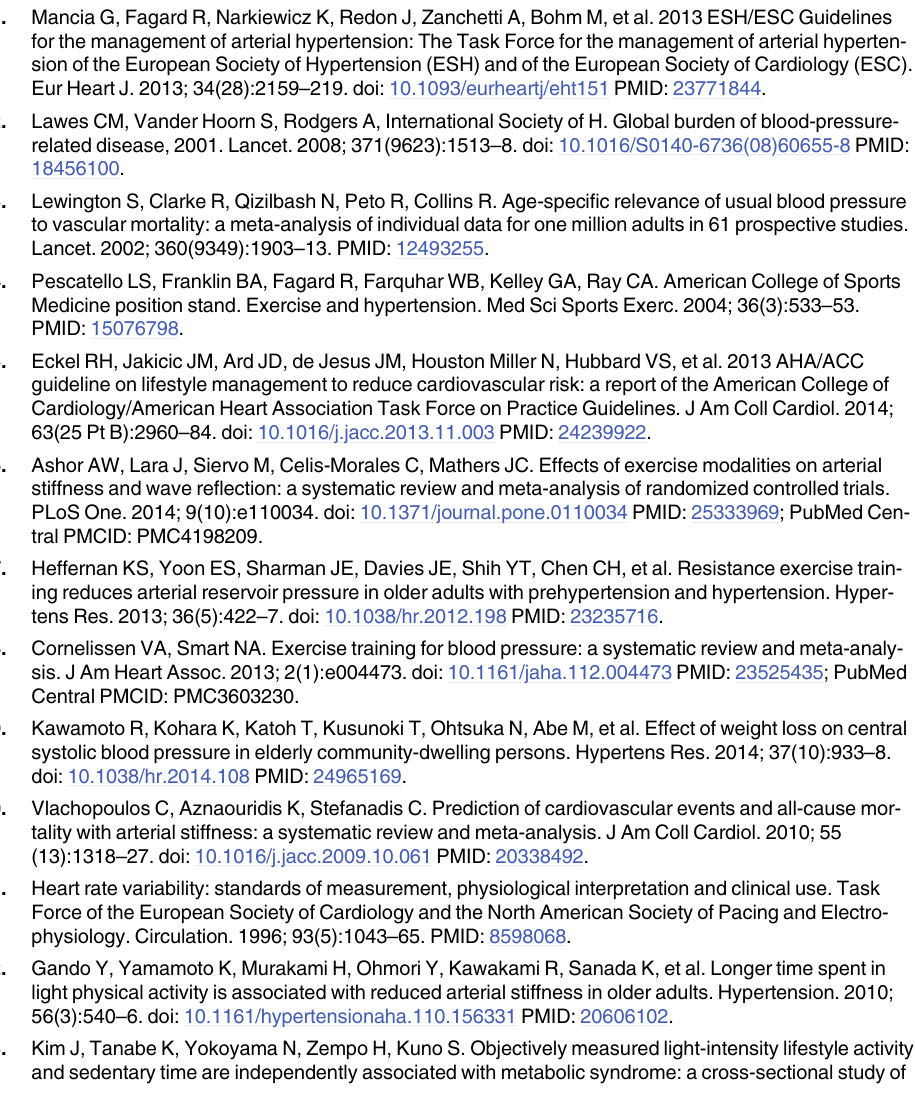
S2 Fig. Relationship between light physical activity and brachial and central blood pressure. LPA = light physical activities; bSBP = brachial systolic blood pressure; bDBP = brachial dia- stolic blood pressure; cSBP = central systolic blood pressure; cDBP = central diastolic blood